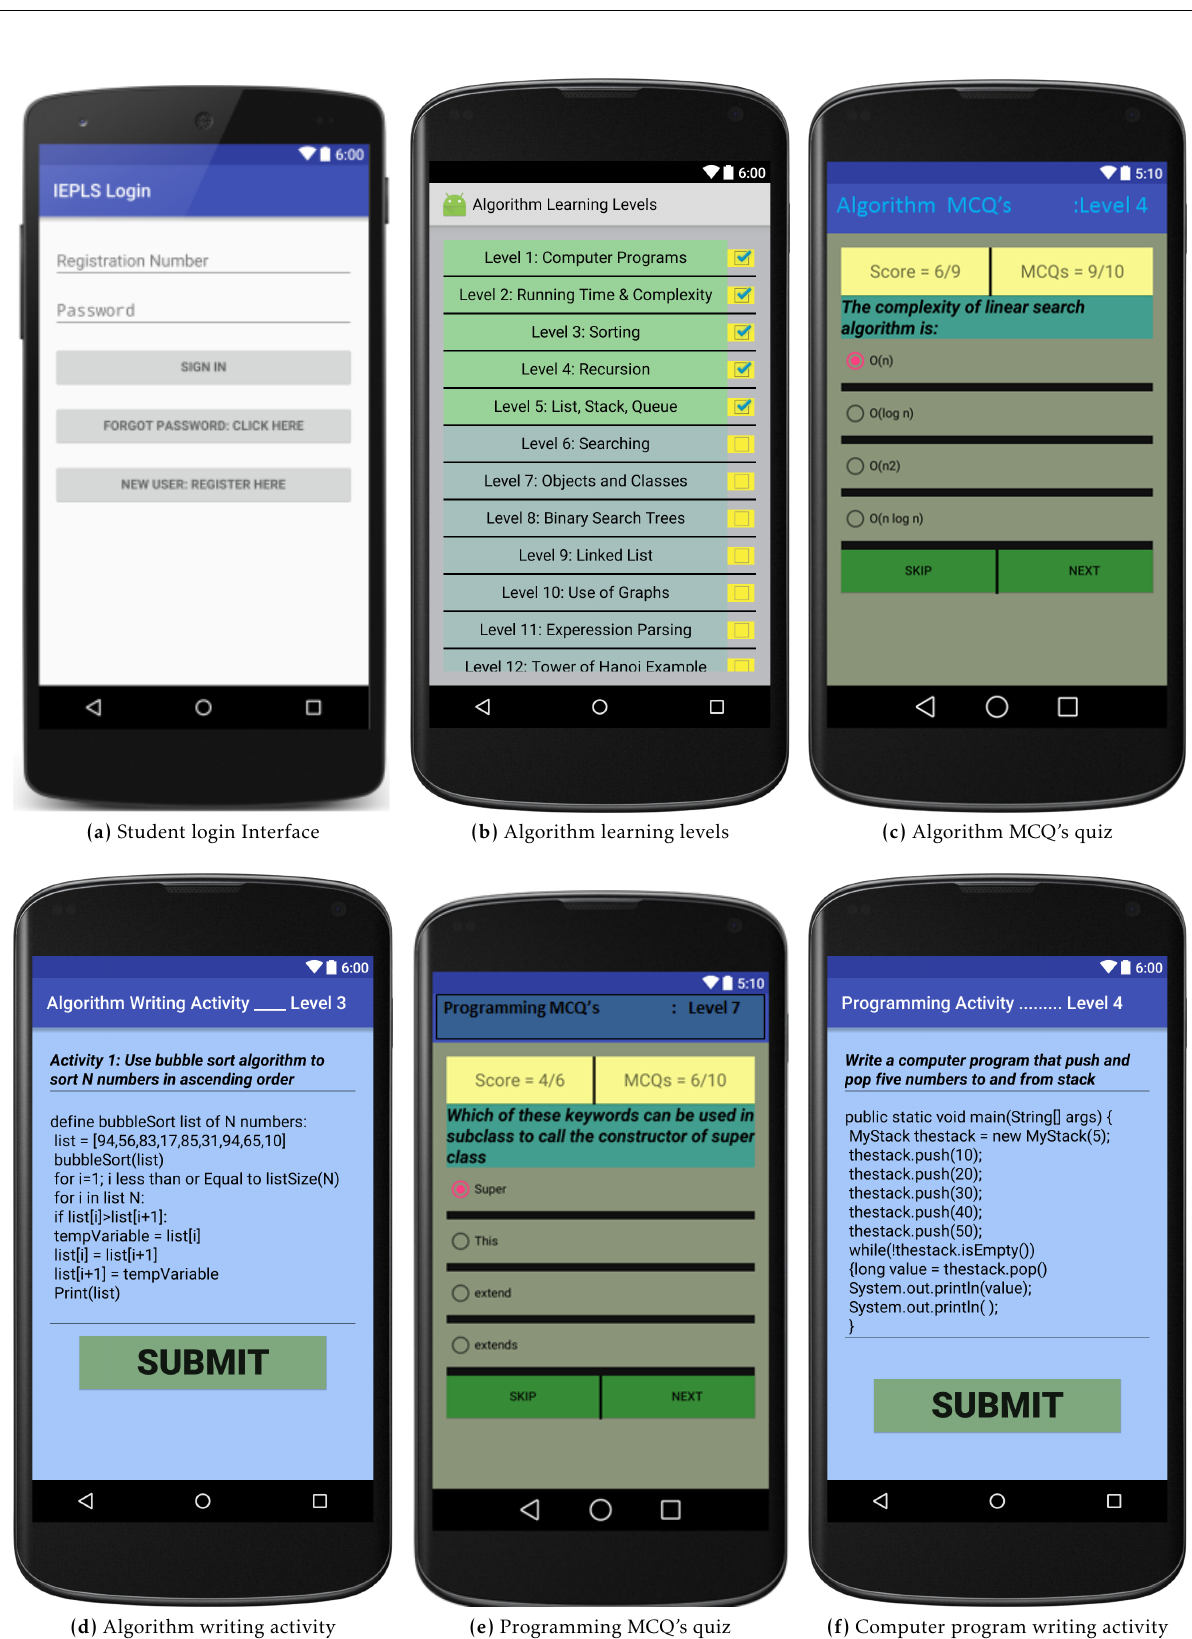
Figure 2. Students’ IEPLS interaction